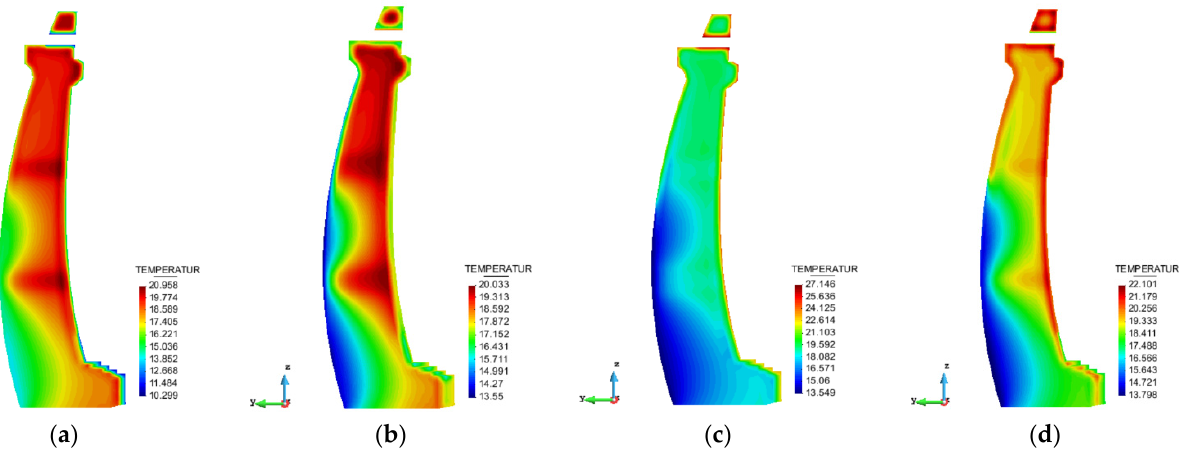
Figure 20. Cloud map of quasi-stable temperature field distribution in cross-section of cantilever No. 16 dam section under measured reservoir water temperature. (unit: °C). ( a ) January; ( b ) April; ( c ) August; ( d ) November.